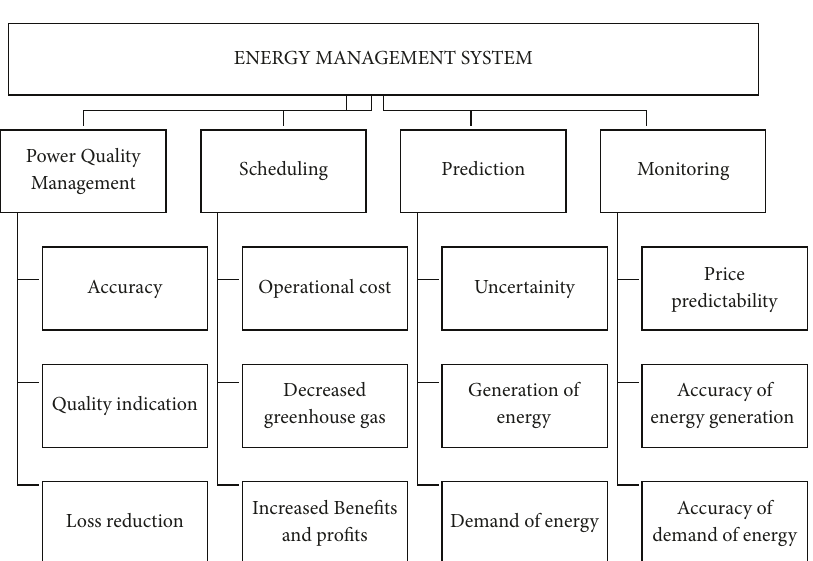
Figure 9: Combination of power quality management with energy management